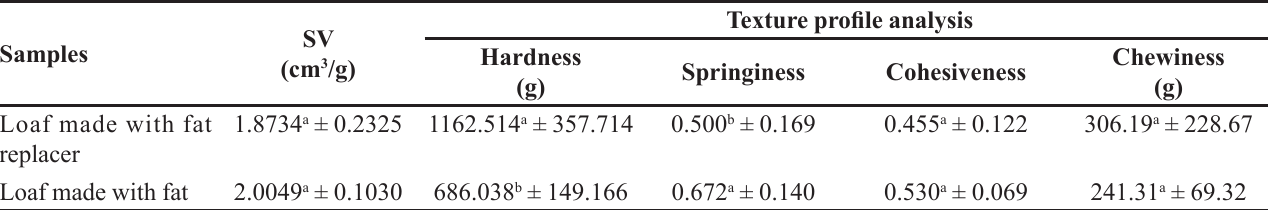
TABLE III - Specific volume and texture profile analysis of bread loaves